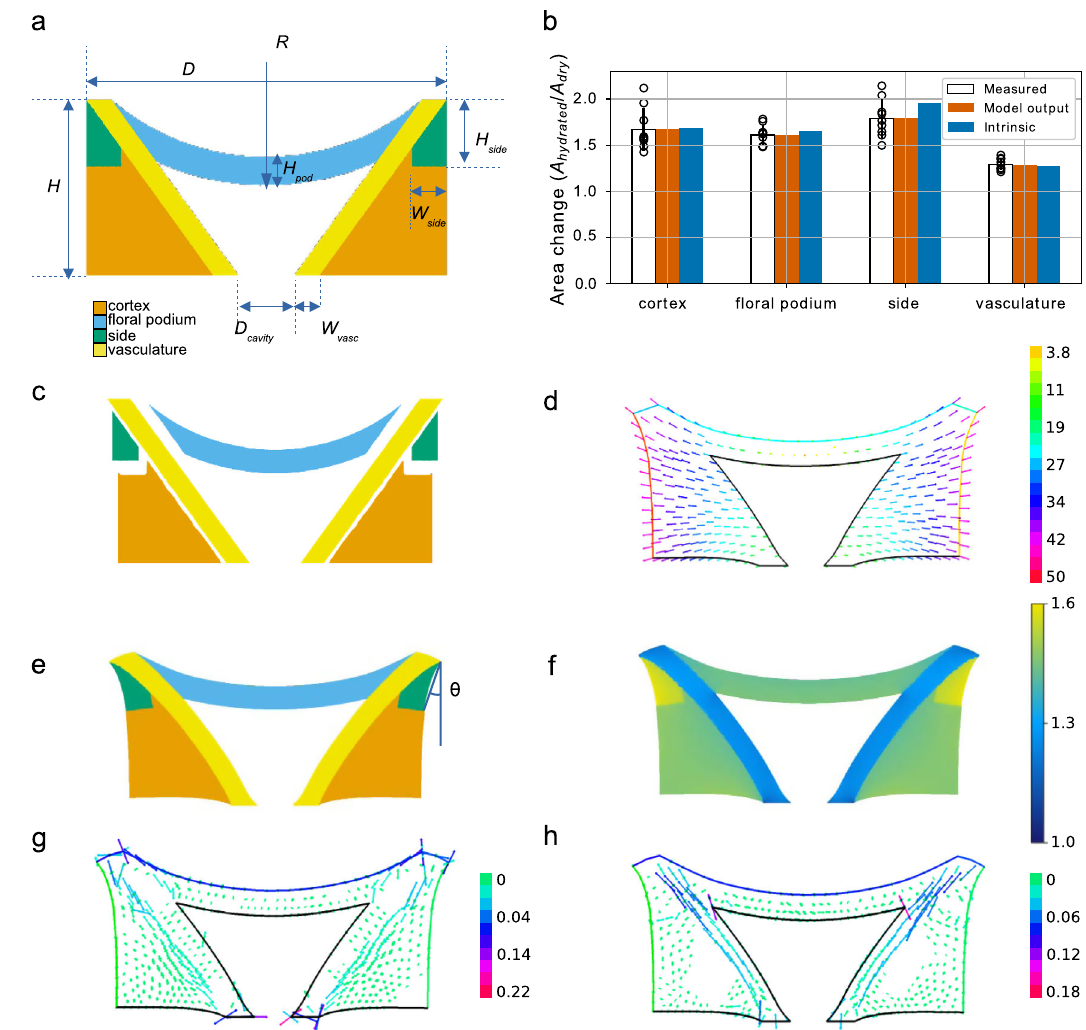
Fig. 5 Computational modelling of apical plate behaviour. a Geometry of the hydrated apical plate with geometrical parameters annotated. The four regions are: fl oral podium (blue), vasculature (yellow), sides (green), cortex (orange). b Observed (as seen in panel e ) and intrinsic (as seen in panel c ) area changes by region compared to the measured area changes. Black bars indicate standard deviation. c Dry state of each region arising from different intrinsic swelling property in a hypothetical setting in which the regions are not attached to each other. d The displacement fi eld relative to the centre of the fl oral podium. e The dehydrated apical plate with regions annotated. Differential intrinsic swelling causes changes in shape due to the fact that they are adhered together. Dehydration generates the holding angle, θ , which is annotated. f Local changes in area across the apical plate. n = 9 biologically independent samples for measured data and is the same dataset as Fig. 4f. g Principal tensile stress in the dehydrated state. h Principal compressive stress in the dehydrated state.